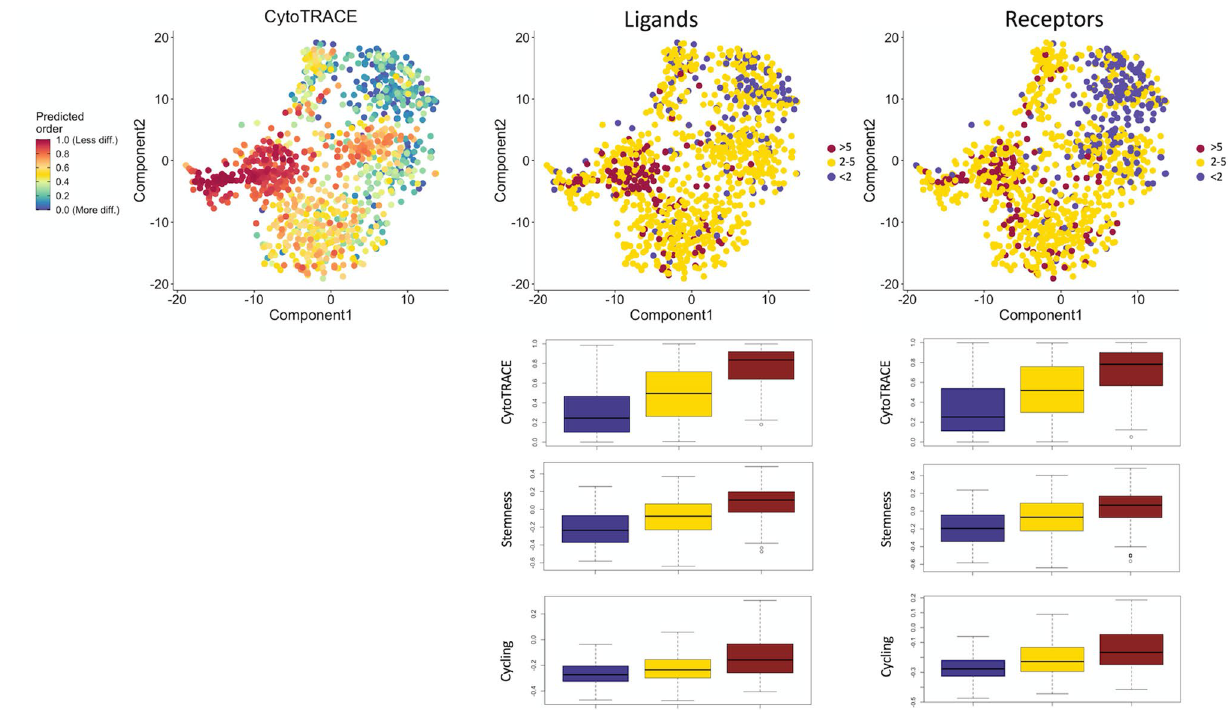
Figure 5. Establishing the developmental hierarchy of SHH medulloblastoma as a function of stromal activation. Top-left: t-SNE embedding of CYTOTRACE output, where less differentiated cells are coloured red and more differentiated cells are coloured blue. The same embedding is coloured by ligand (top-middle) and receptor (top-right) density of stroma-associates, suggesting “stroma-active” cells have greater developmental potential than “stroma-inactive” cells. Boxplots are used to compare stemness and cycling properties of cells expressing < 2, 2–5, and > 5 receptors and ligands, using both CYTOTRACE output and previously established “stemness” and “cycling” gene signatures. ANOVA p < 0.0001 in all